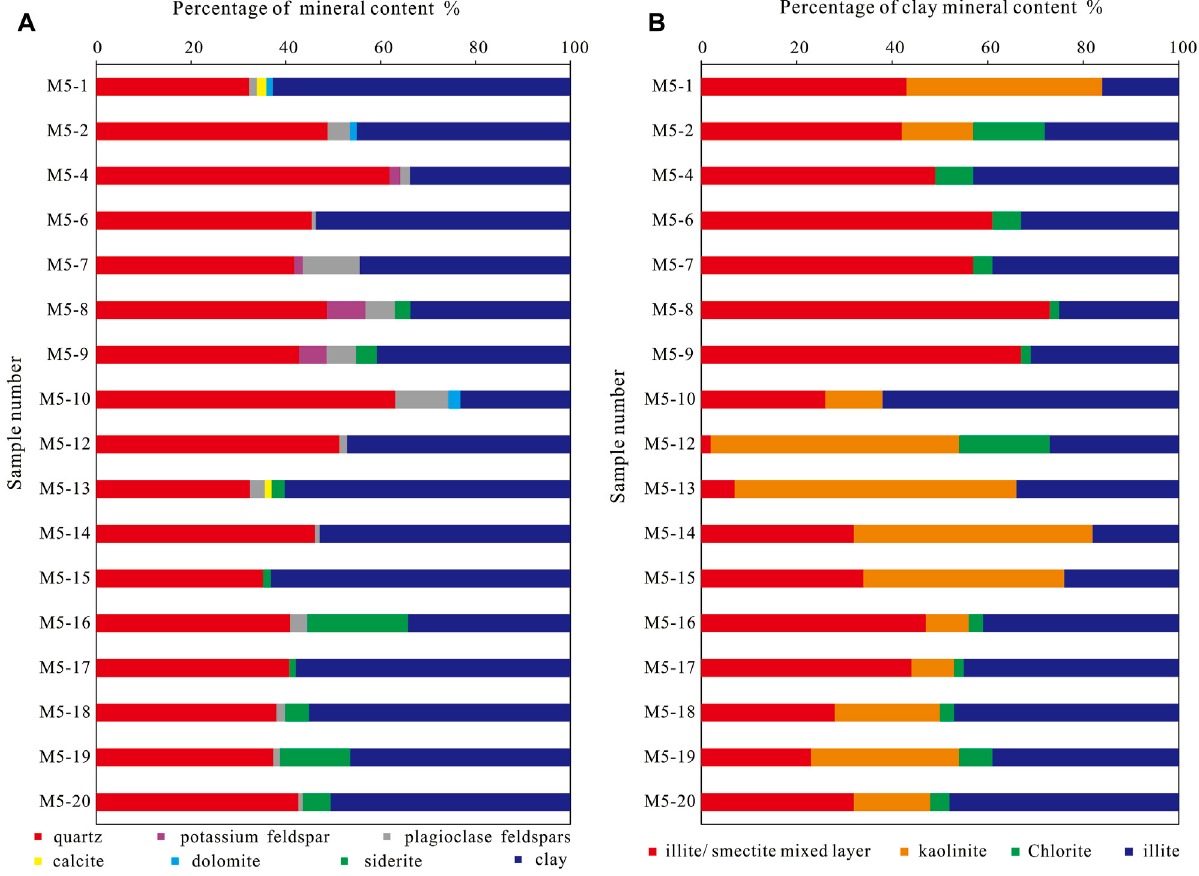
Frontiers in Earth Science |